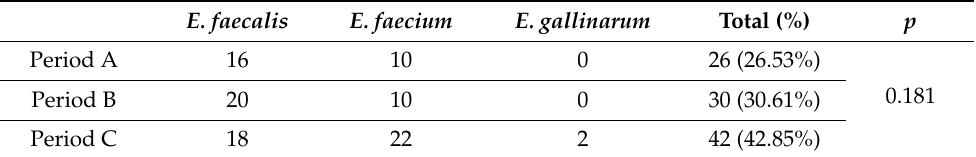
Table 5. Number of infections with Enterococcus spp. during the time of this